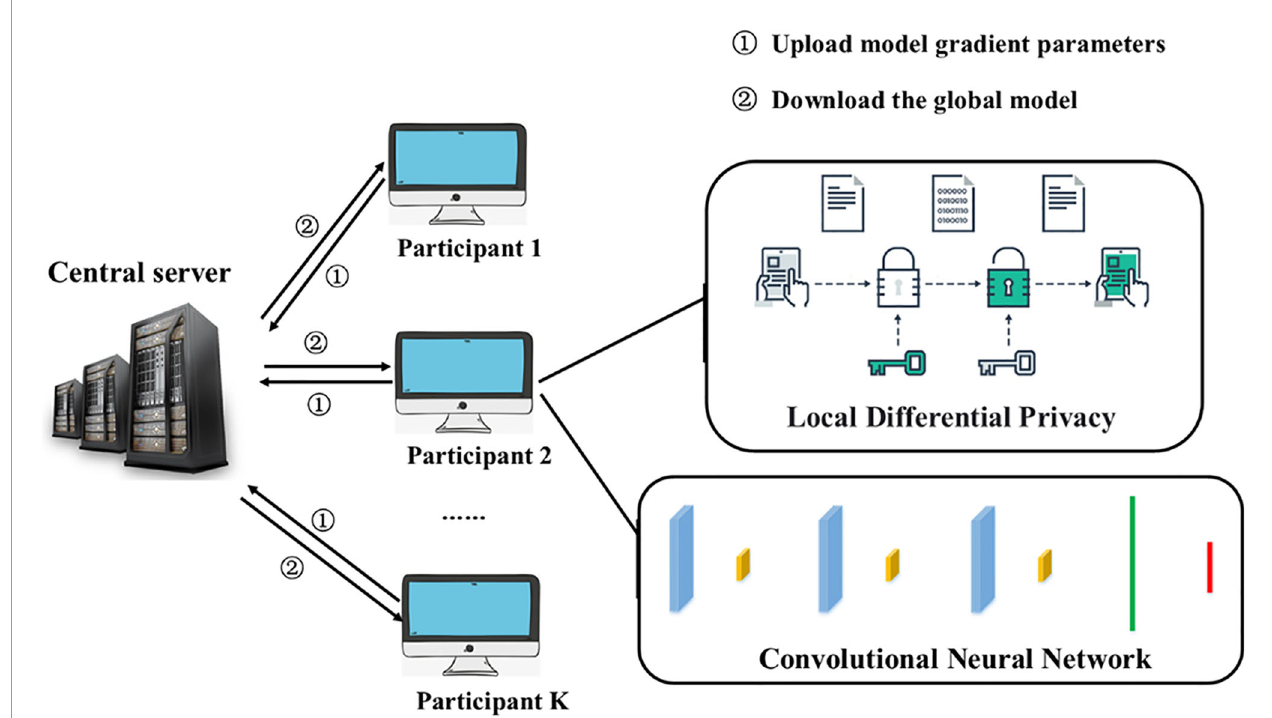
FIGURE 3 | CNN-FL model